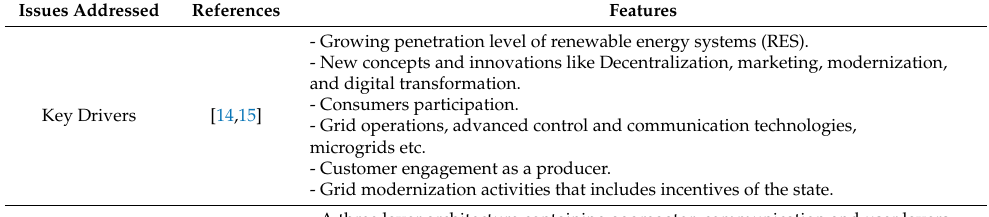
Table 2. Various issues addressed and their salient